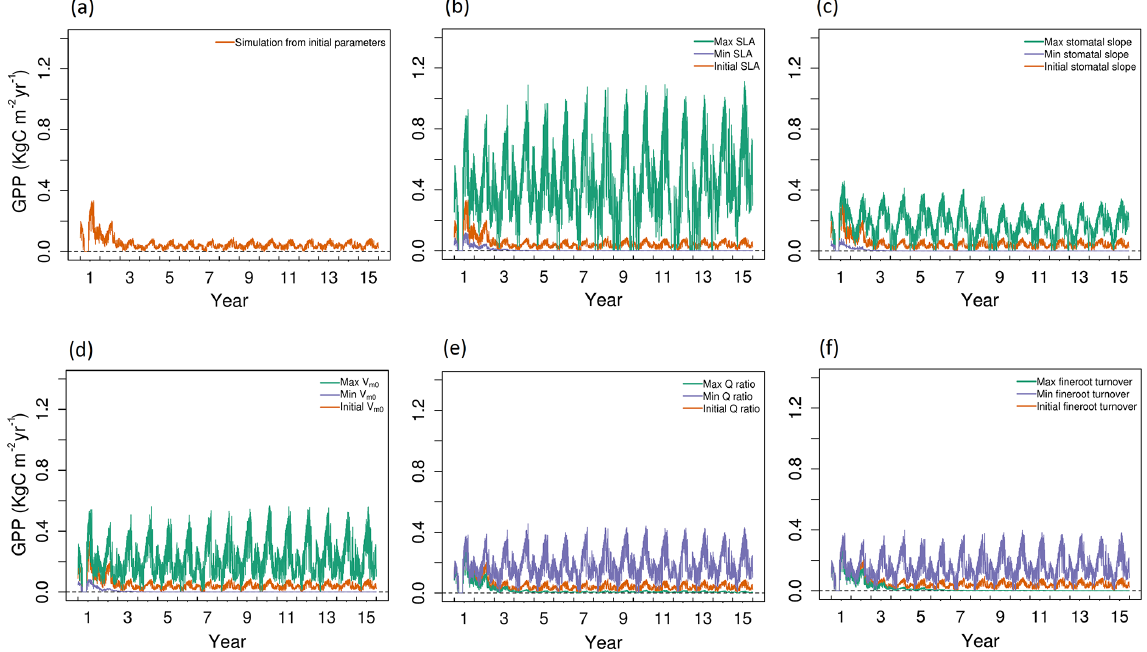
Figure 2. Simulated daily GPP outputs from 1 to 15 years for the study location with (a) initial values of all five parameters and (b– f) maximum (green), minimum (blue), and initial (red) parameter values for SLA, stomatal slope, V m , 0 , Q ratio, and fine root turnover